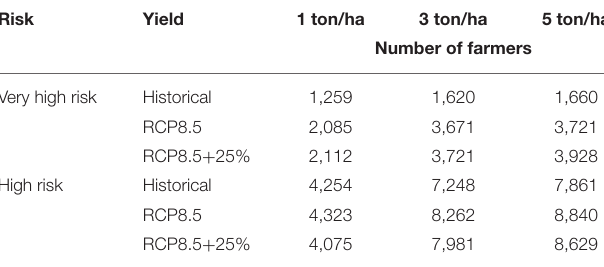
TABLE 5 | Number of farmers with low rainfed maize yield in very high and high-risk categories. Risk Yield 1 ton/ha 3